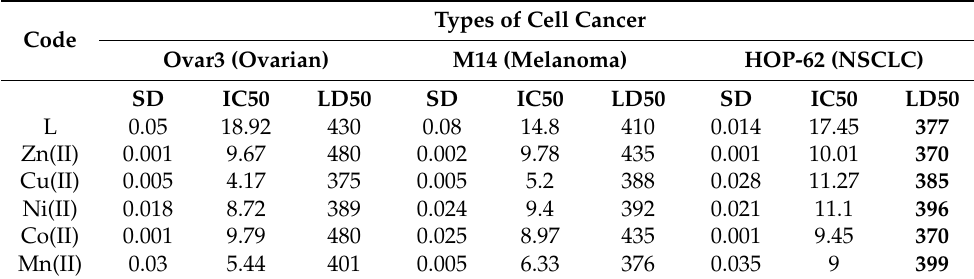
Table 6. In vitro anticancer activity of (Ovra3), (M14), and (HOP-62) cancer cell lines.